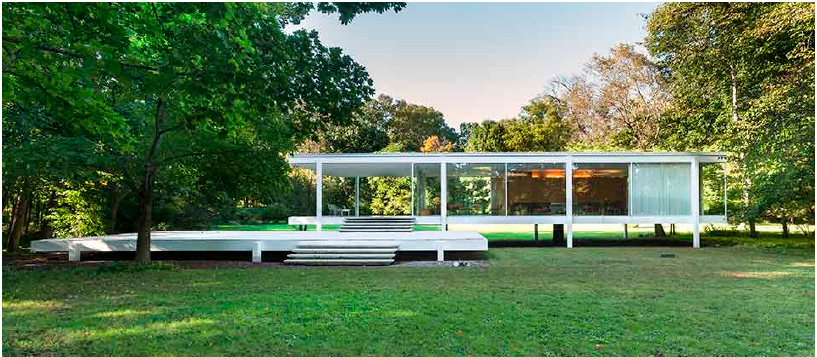
Figure 11. Farnsworth House by Mies Vand der Rohe, Illinois, 1950 [21].